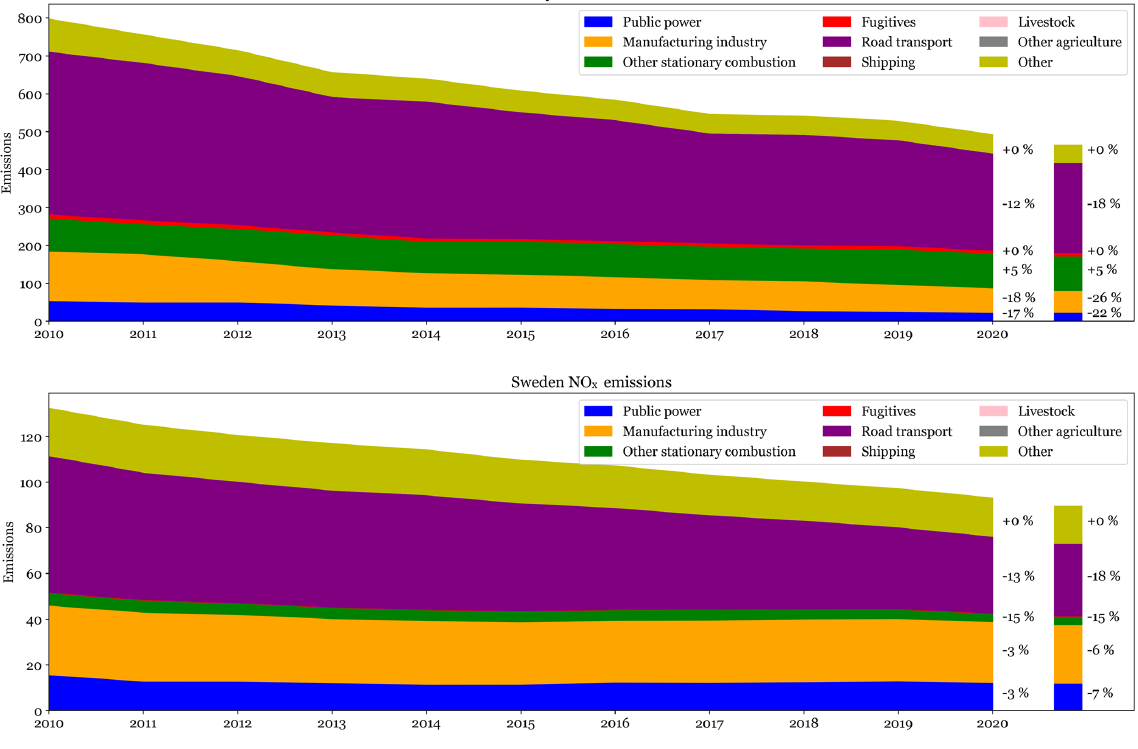
Figure 1. Time series of NO x emissions [kgyr − 1 ] for Italy and Sweden. Up to 2018, official reported emissions are used. For 2019 and BAU 2020, emissions are estimated. For 2020, a second estimate is made (separate bar on the right) that includes AD affected by COVID-19. Percentages refer to the difference compared to